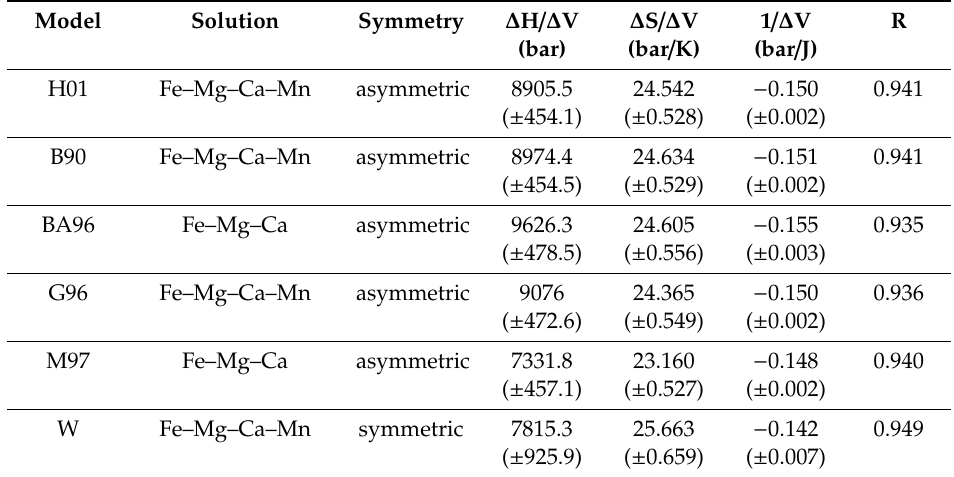
Table 1. Regressed parameters in calibrating the garnet geobarometer using different activity models of garnet *.